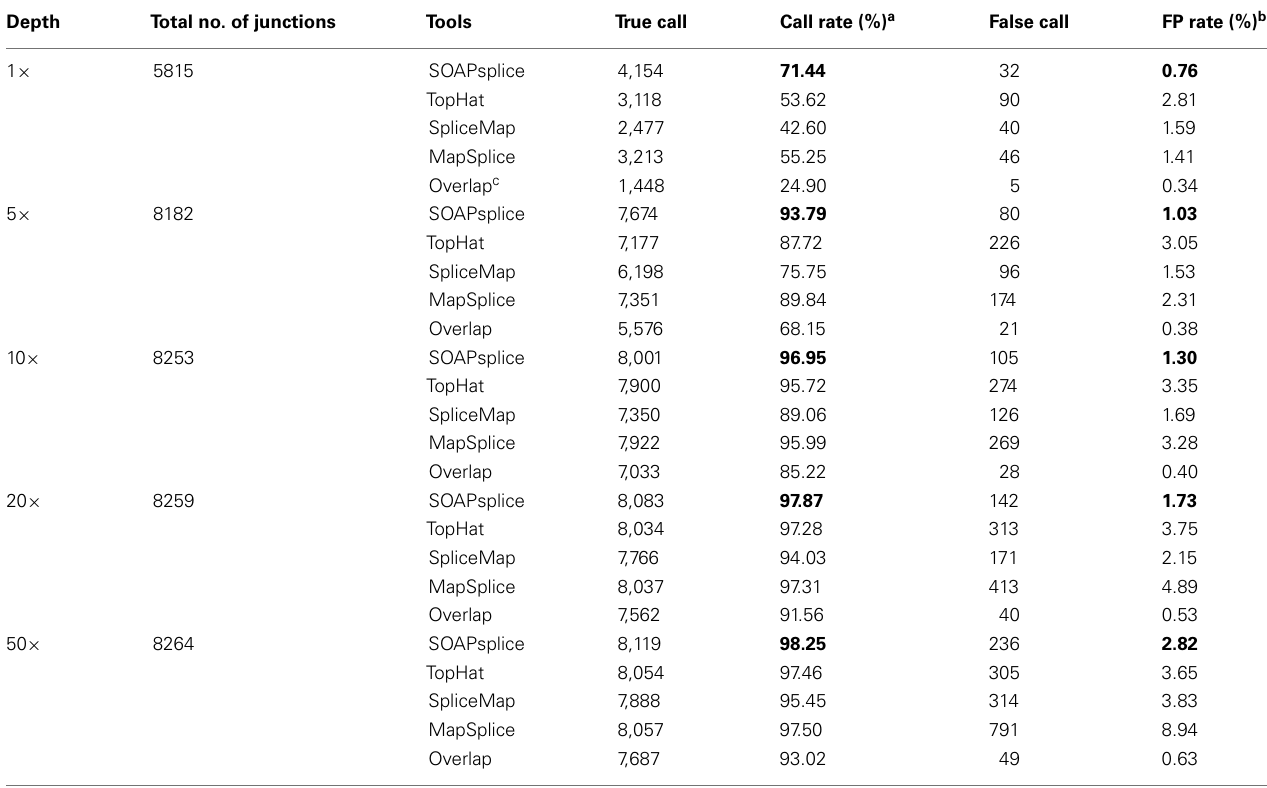
TableA3 | Statistics of the junctions detected on the 75-bp simulated reads.